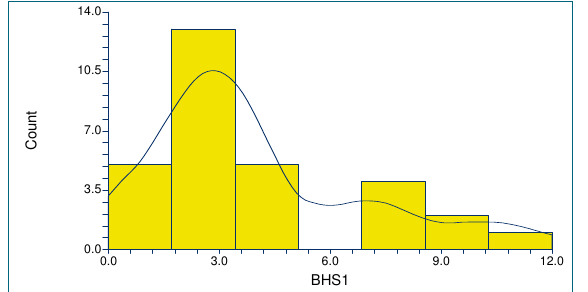
Fig. 1. Histogram of Beck’s Hopelessness Scale taBle i. FreQUencY oF BecK’S HoPeleSSneSS Scale ScoreS in relation to Patient VariaBleS